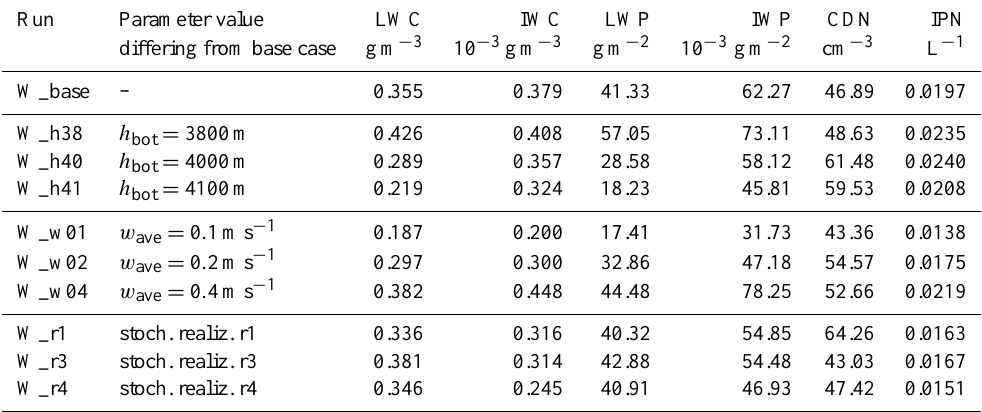
Table 1. Overview of the model results for the dynamic sensitivity runs for the warmer case 1 (maximum values of L/IWC: liquid/ice water content; L/IWP: liquid/ice water path; CDN: cloud drop number; IPN: ice particle number).